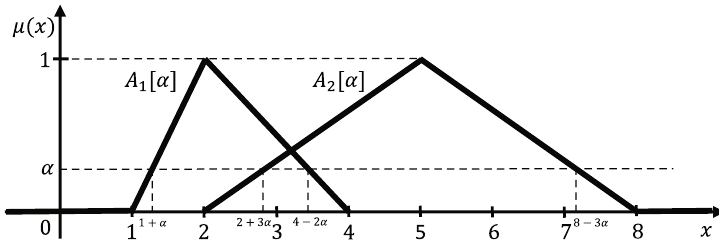
~ ~ ~ A 2 where A 1 ≼ A 2 1 and